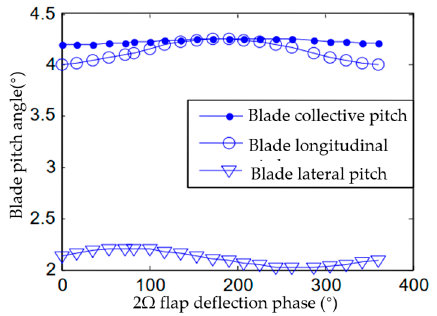
Figure 9. The effect of change in the 2 Ω flap phase on the pitch.